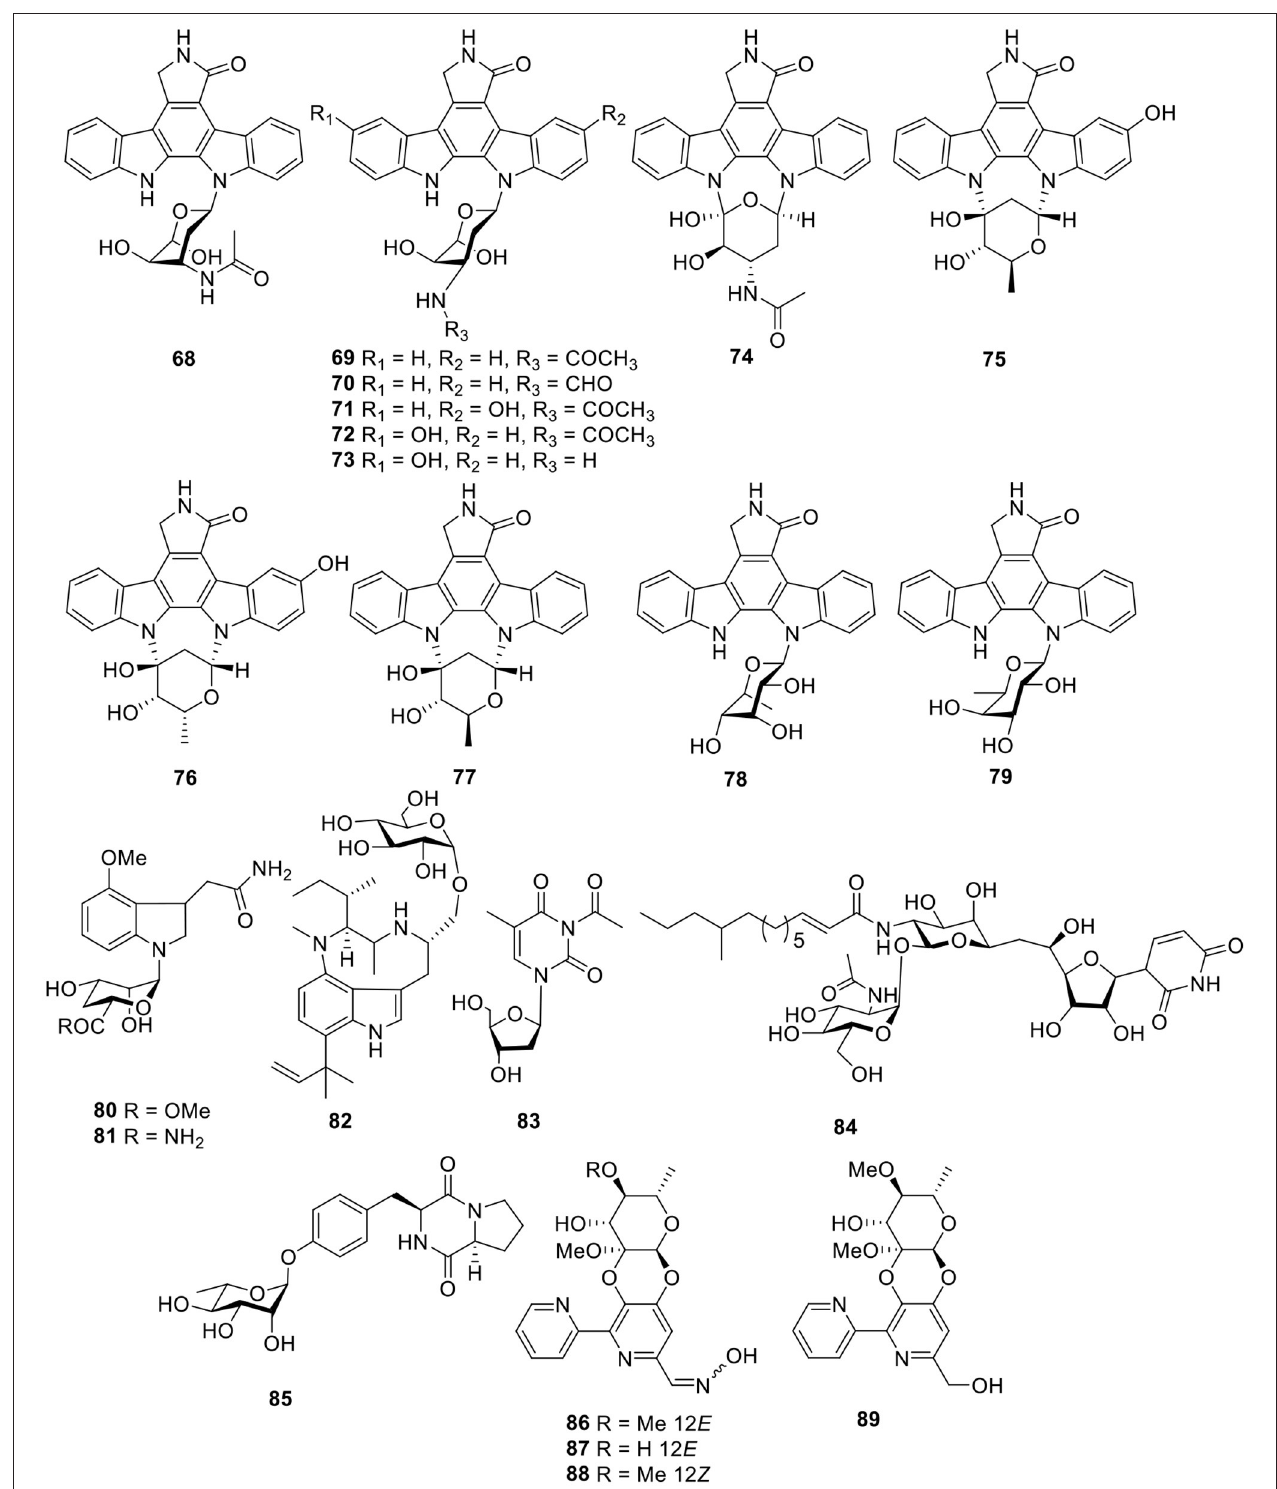
FIGURE 6 | Chemical structures of compounds 68–89 derived from marine-sourced bacteria.